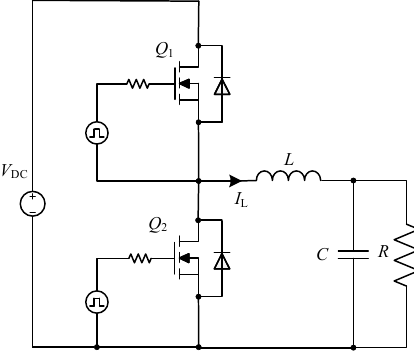
Figure 1. Synchronous buck converter.